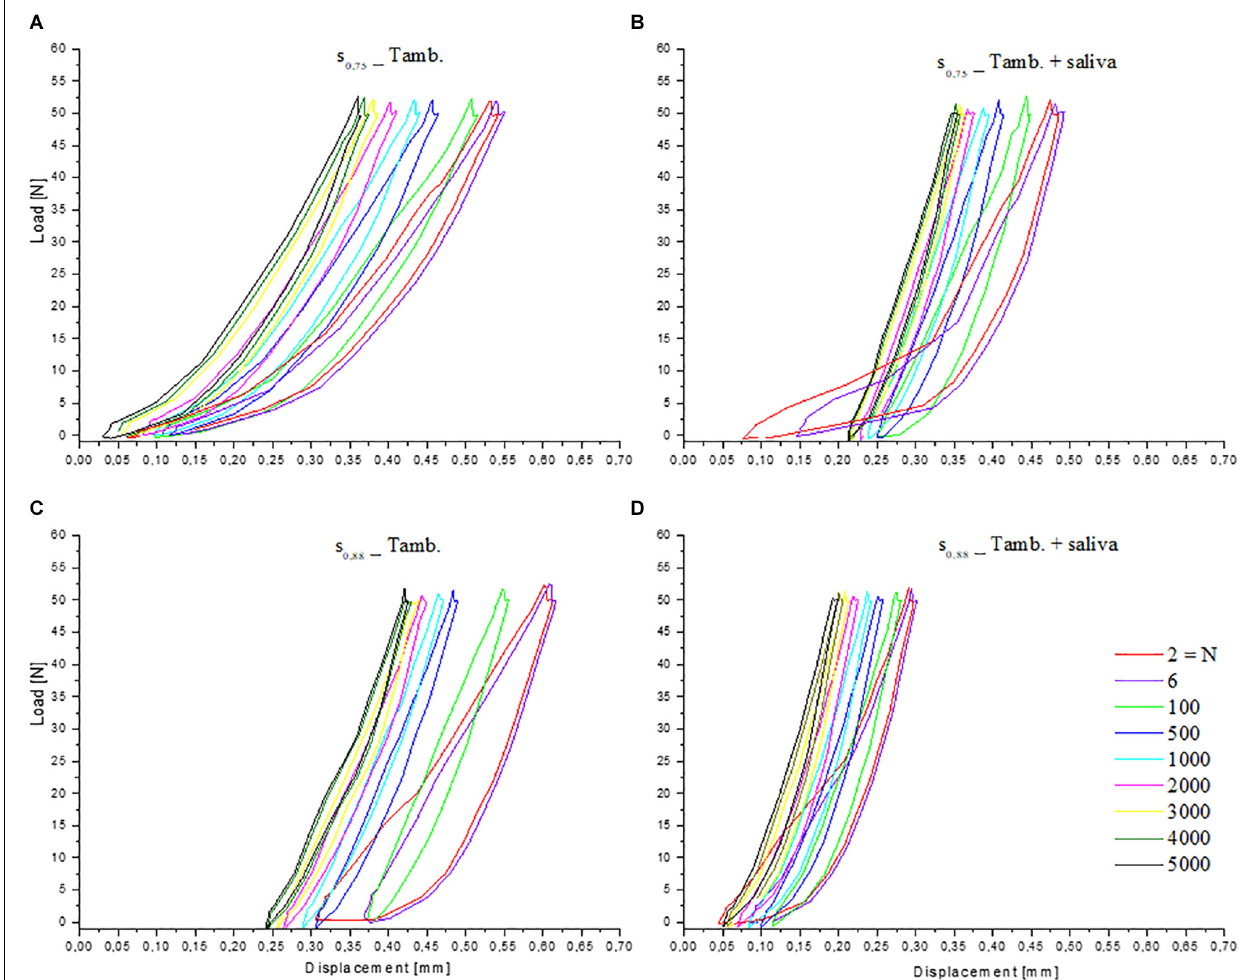
FIGURE 4 | Evolution of the load–displacement loops for each sample tested under different environmental conditions. 0.75 mm sample tested (A) in atmospheric environment ( ∼ 25 ◦ C) and (B) in presence of artificial saliva. 0.88 mm sample tested (C) in atmospheric environment ( ∼ 25 ◦ C) and (D) in presence of artificial saliva. The serial number of the compression cycle ( N ) increases from right to